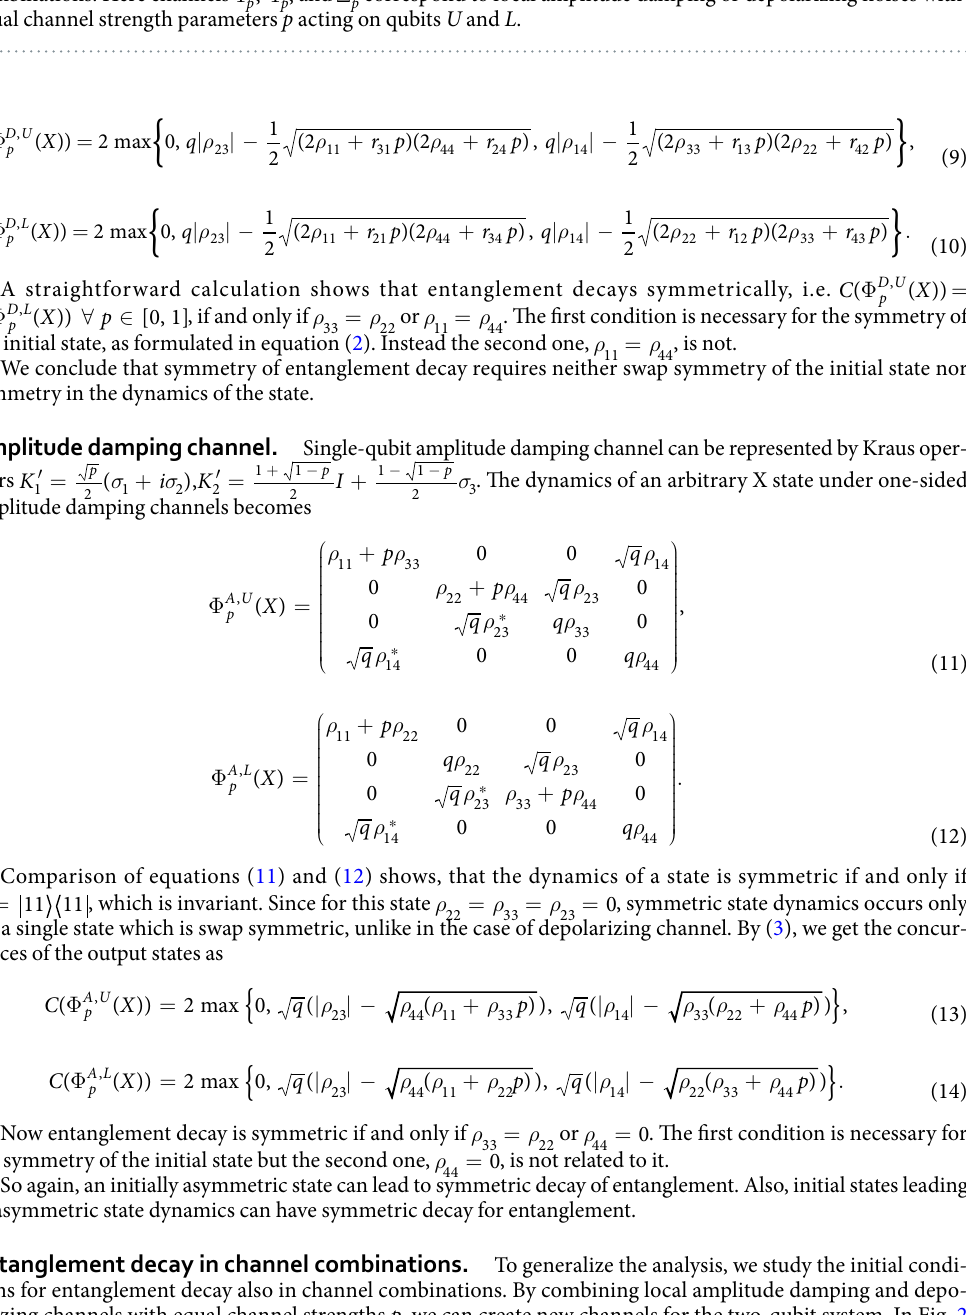
Figure 2. Schematic illustrations ( a ), ( b ), ( c ) and ( d ) visualize four different geometric configurations for noise combinations. Here channels Φ Ψ , ,